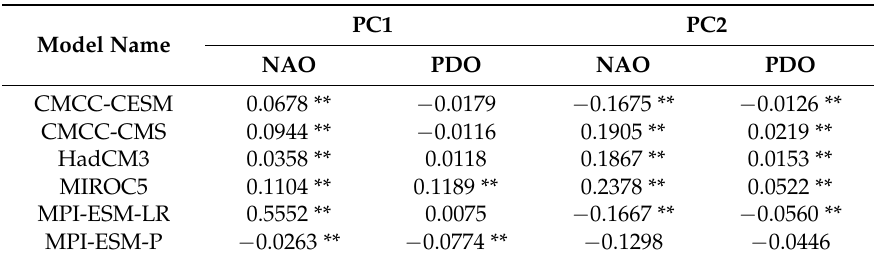
Table 3. The Correlation coefficients between the climate indices and the first two principal components (PCs) of the six top models in Central